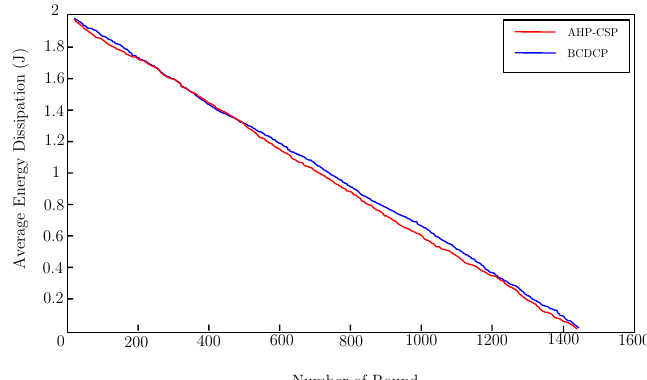
Figure 8. A comparison between AHP-CSP and BCDCP in terms of average energy dissipation.